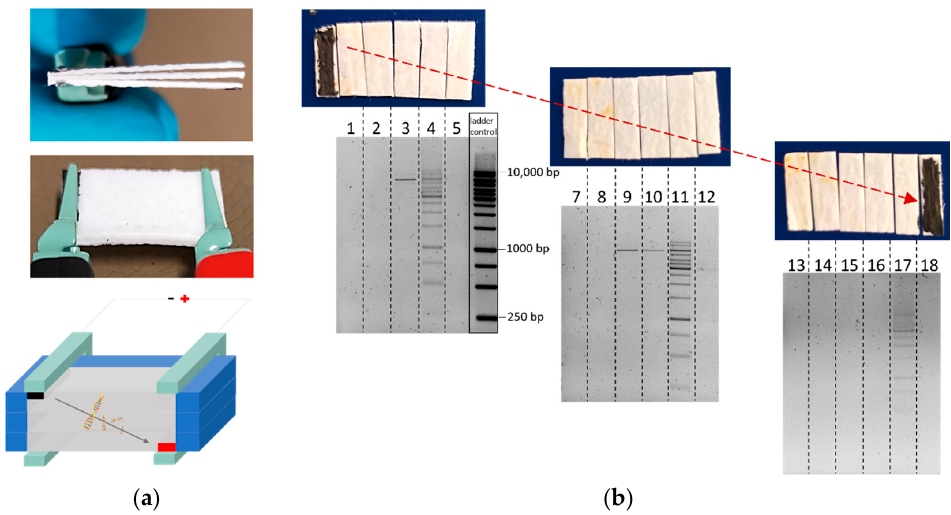
Figure 11. Cross-layer chip consisting of three layers of glass microfiber connected via the upper left and lower right electrode to generate an oblique migration direction through all layers. ( a ) Pictures and illustration of the cross-layer chip connected by crocodile clamps. The schematic illustration does not correspond to the actual height–length ratio. ( b ) Elution fractions of each layer after agarose gel electrophoresis.